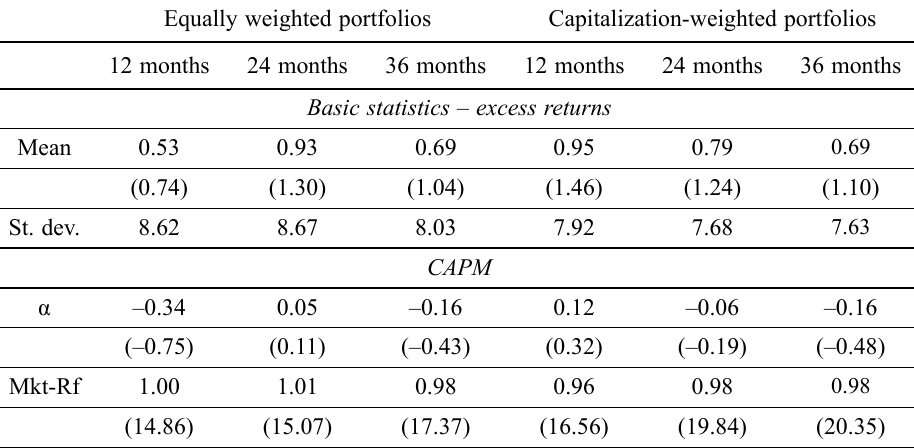
Table 3. Long-term performance of acquiring companies Equally weighted